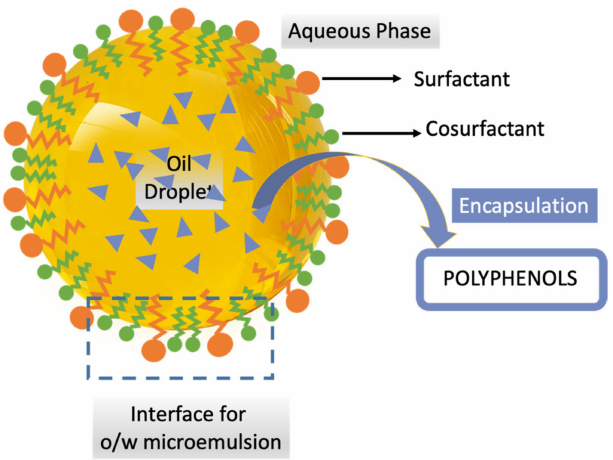
Figure 5. Schematic representation of the droplet structure of an oil-in-water microemulsion carrying polyphenolic